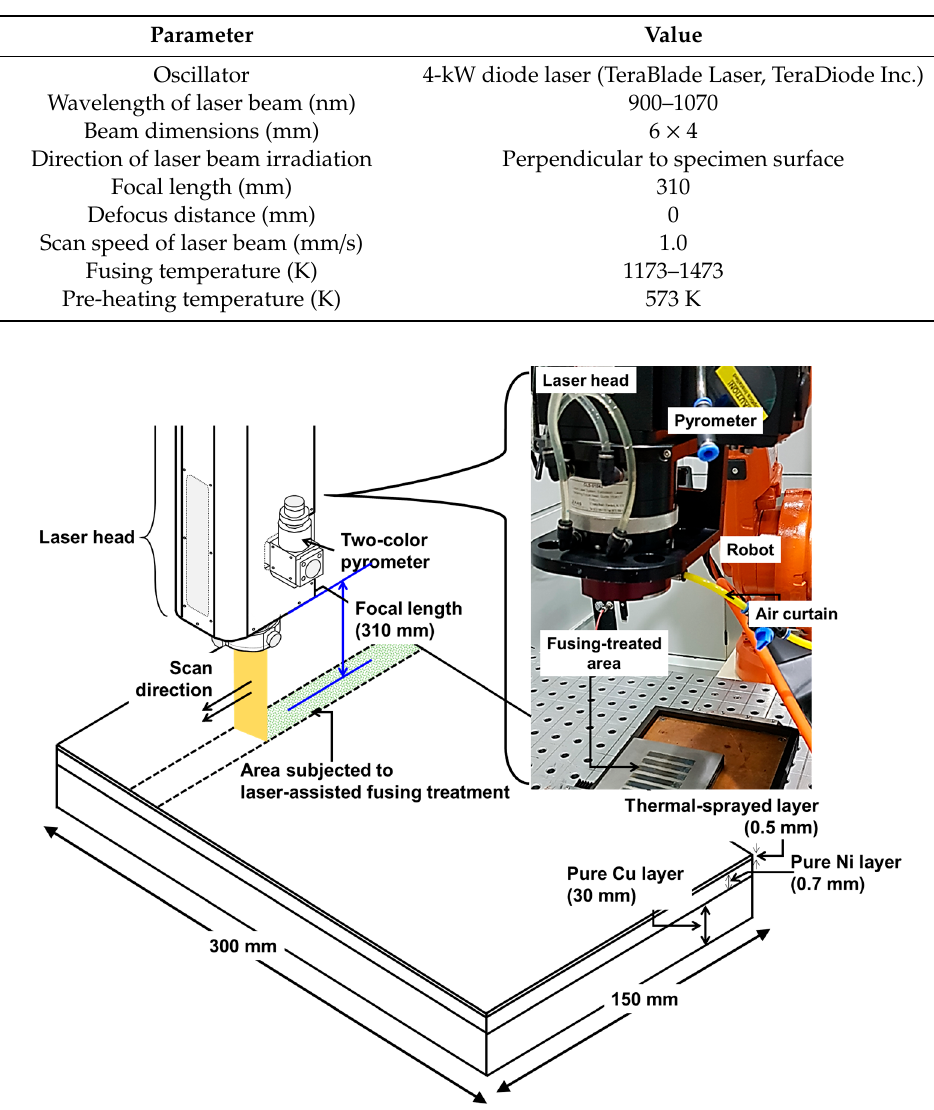
Figure 1. Experimental setup for laser-assisted fusing treatment and specimen arrangement. Table 3. Laser-assisted fusing treatment conditions.